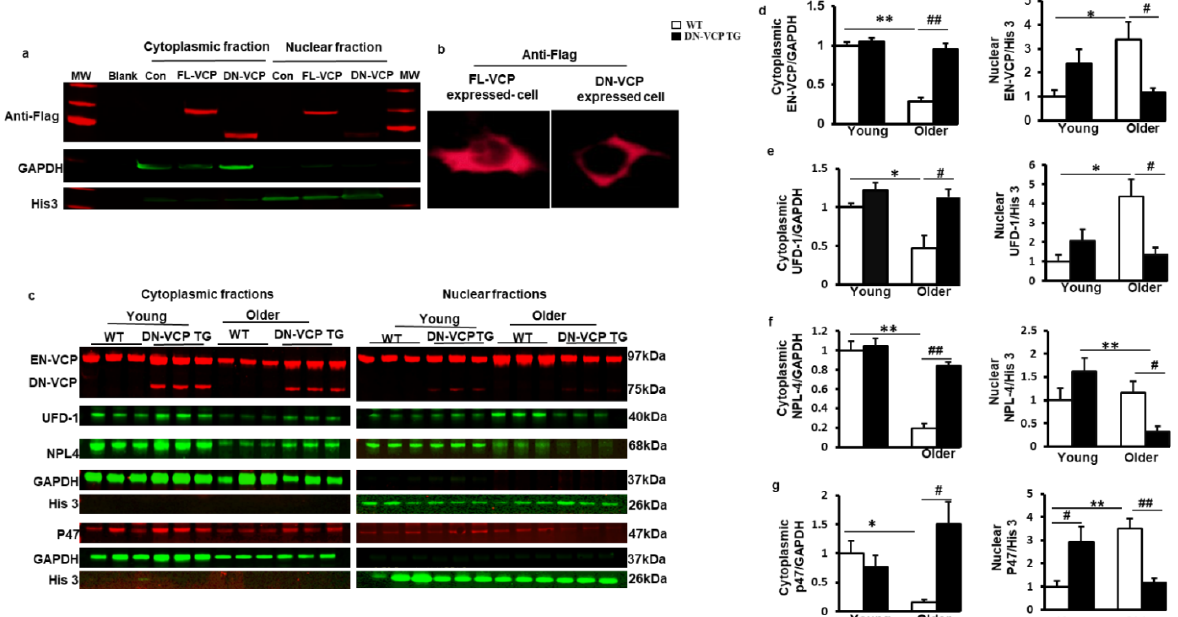
Figure 4. DN-VCP impairs its nuclear localization and attenuates the age-related cytoplasmic/nuclear shuffling of the EN-VCP and its co-factors/adaptor in TG mouse hearts. ( a , b ). The subcellular distributions of overexpressed full-length VCP (FL-VCP) and dominant-negative VCP (DN-VCP) in the cytoplasmic and nuclear fractions of the cells, with a specific antibody against the tag-protein-Flag, by Western blots ( a ) and cytoimmunostaining ( b ). Plasmid with vector-only was used as control (Con); ( c ). The representing Western blots reflected the subcellular compartmentalization of the corresponding proteins in the DN-VCP TG mouse heart tissues and compared to their age-matched WT mice at both young and older ages, including endogenous VCP (EN VCP), dominant-negative VCP (DN-VCP) and co-factors, ubiquitin fusion degradation protein 1 (UFD-1), nuclear protein localization protein 4 (NPL-4), and P47. GAPDH was used as a loading control of the cytoplasmic proteins, and Histon 3 (His 3) was used as a loading control of nuclear proteins; ( d ). The relative values of EN-VCP in cytoplasmic and nuclear fractions, respectively; (e – g ). The relative values of VCP-cofactors in cytoplasmic and nuclear fractions, respectively, including UFD-1 ( e ), NPL-4 ( f ), and P47 ( g ). The cytoplasmic proteins were normalized to the GAPDH, and the nuclear proteins were normalized to the Histon 3 (His 3). The relative value was presented by the fold of the WT young mice. *, p ≤ 0.05, **, p ≤ 0.01 vs. corresponding young mice; #, p ≤ 0.05, ##, p ≤ 0.01 vs. age-matched WT mice .